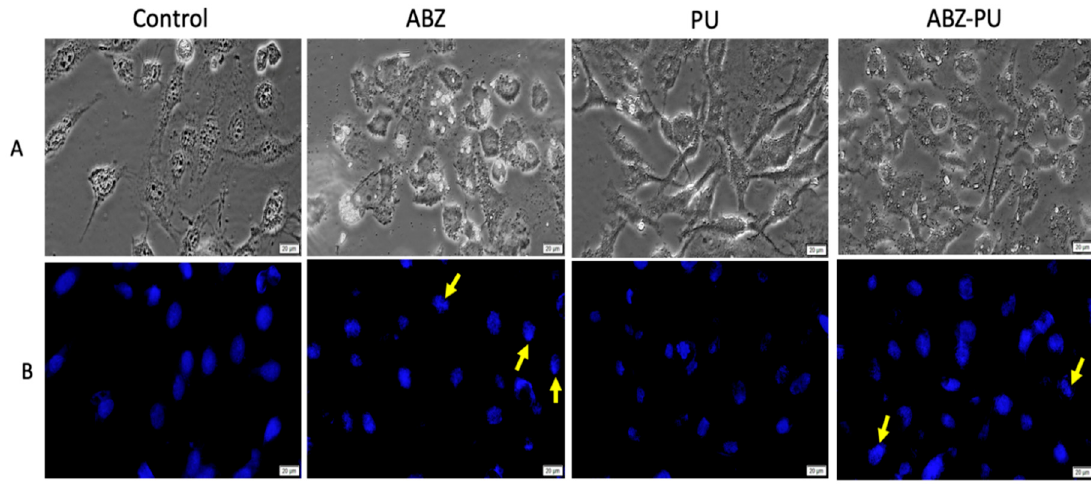
Figure 12. MDA-MB-231 cells stimulated with the highest concentration (100 µM) of test samples (ABZ, PU, ABZ-PU) for 24 h. ( A )—Bright field microscopy was used to observe the cell morphology; ( B )—Hoechst staining was employed to assess the specific apoptotic markers (chromatin condensation/DNA fragmentation). Scale bars represent 20 µm.